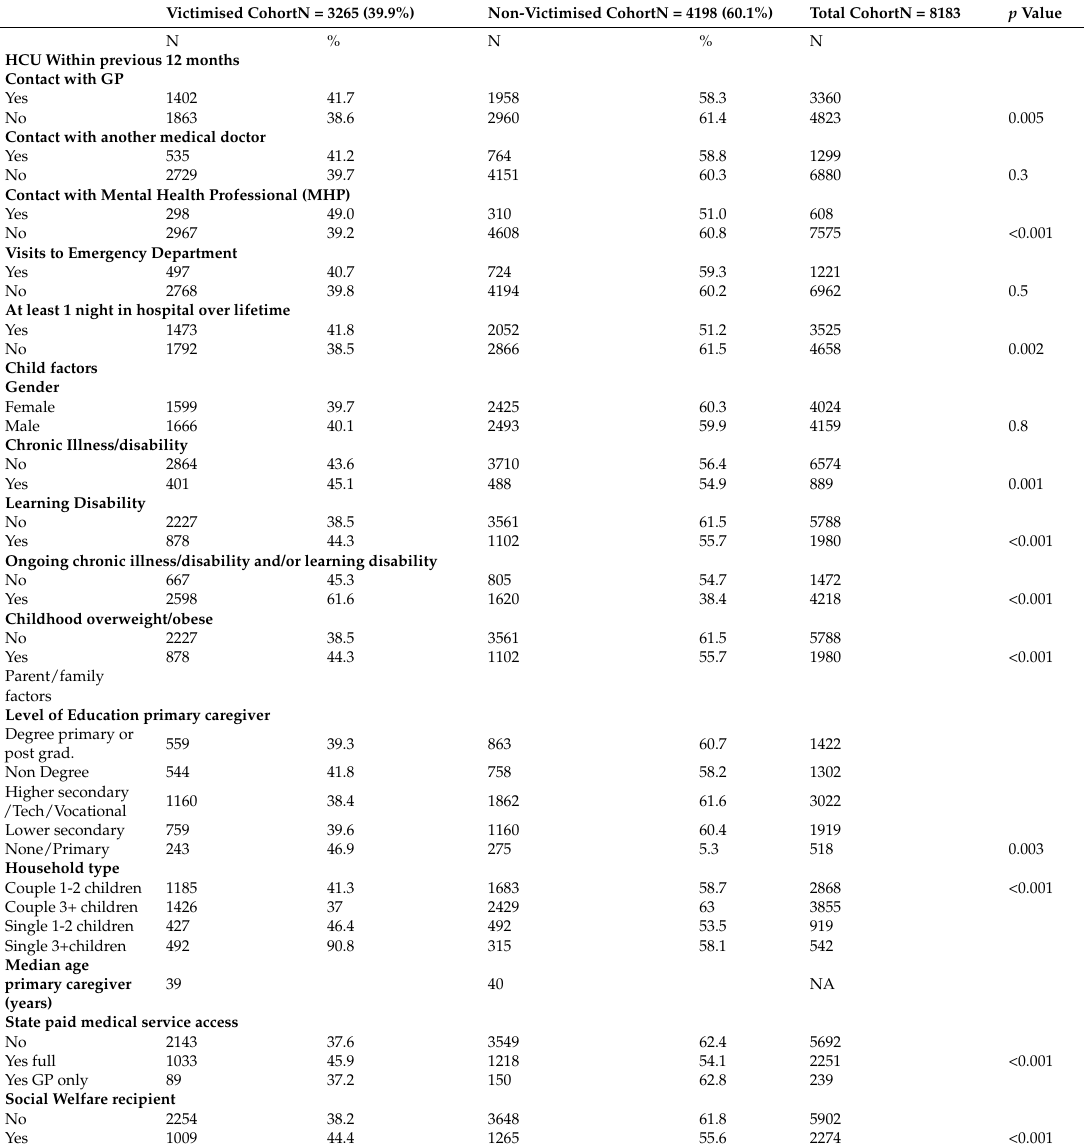
Table 2. Univariate analysis of health care utilisation, child health and socio-demographic characteristics in victimised and non-victimised cohorts (total cohort N = 8183). Victimised CohortN = 3265 (39.9%) Non-Victimised CohortN = 4198 (60.1%) Total CohortN =